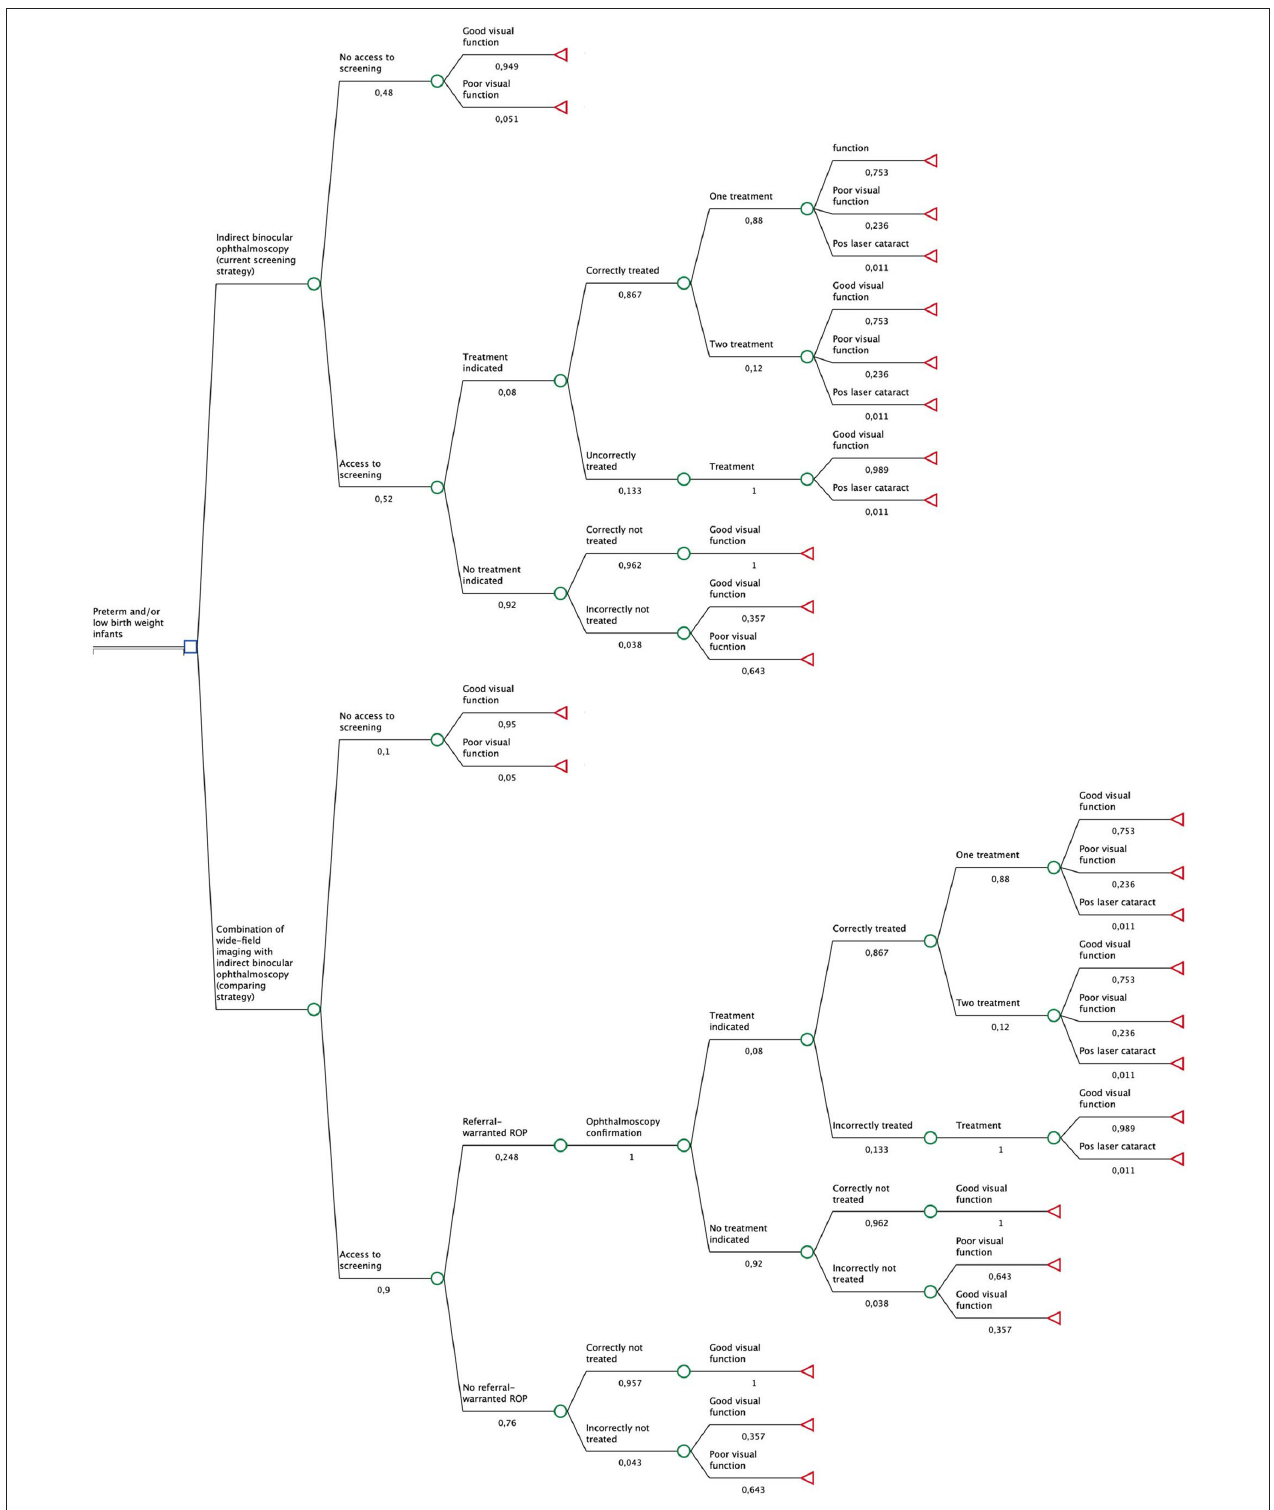
FIGURE 1 | Decision analytic model for ROP care in preterm and/or low birth weight infants with two strategies: the current stratagy, indirect binocular ophthalmoscopy, and the comparing strategy, combination of wide-field imaging with indirect binocular ophthalmoscopy. The number under the branches of the decision tree represents the probability of each parameter branch to